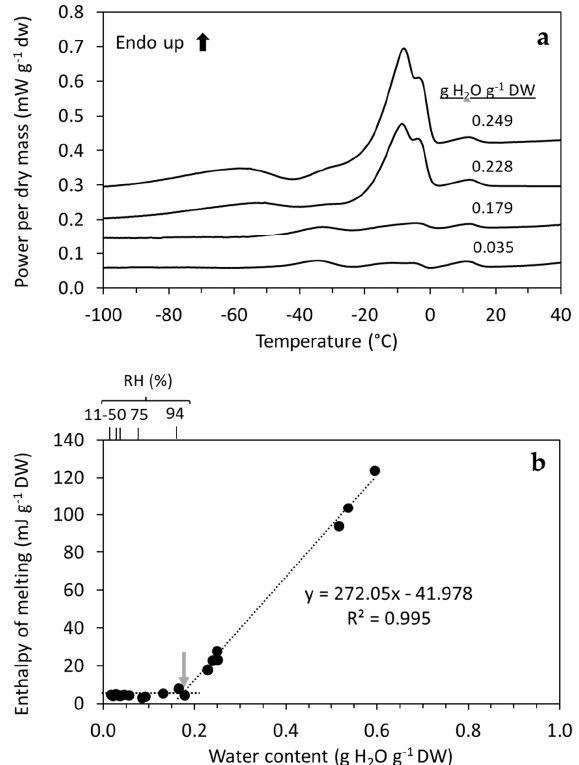
Figure 1. Influence of temperature and water content on ice melting events detected via DSC. ( a ) Effect of WC on the profile of first order transitions (peaks) in heating DSC scans from − 100 °C to 40 °C of H. lacustris cells. For clarity, scans from cells >0.035 g H2O g − 1 DW have been stacked above one another, thus Y-axis values are not absolute. ( b ) Relationship between water content and enthalpy of melting (i.e., peak size in ( a )), revealing that unbound and freezable water only occurred in cells above 0.171 g H 2 O g − 1 DW (grey